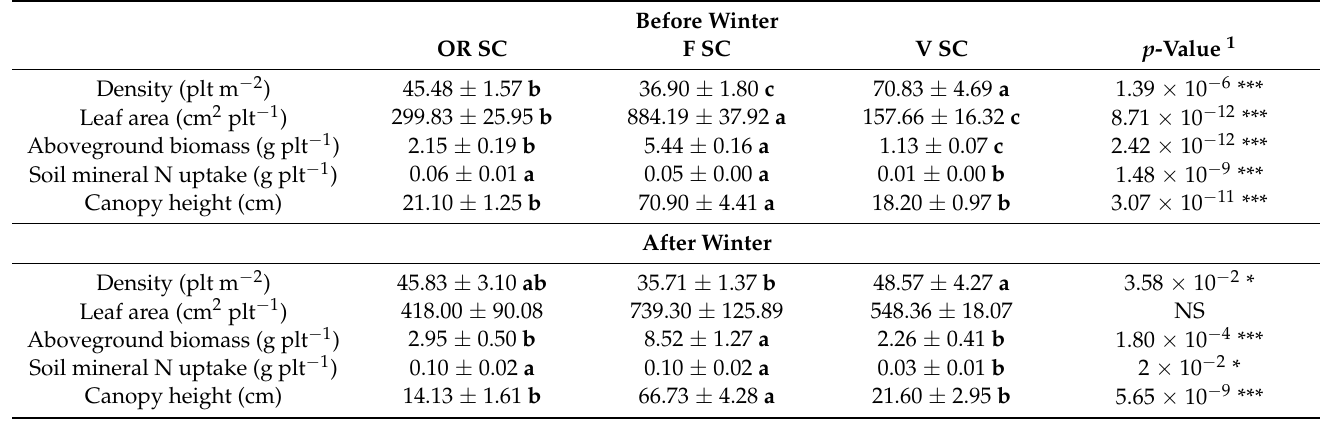
Table 3. Comparison of aboveground variables and soil mineral N uptake between three sole crops: oilseed rape (OR), faba bean (F) and common vetch (V) growth and soil N uptake as sole crops (SC) before winter in December and after winter in February. Values are mean ( n = 8) ± standard error for 2013/14 and 2015/16 except for crop leaf area after winter ( n = 4) ± standard error, which was measured only in 2013/14. Before Winter OR SC F SC V SC p -Value 1